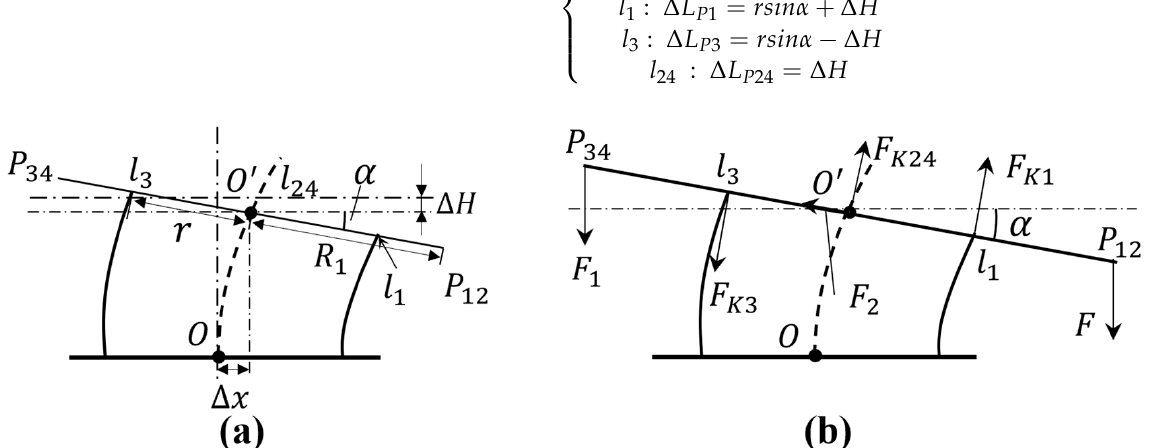
Figure 8. Analysis of the bending movement of the upper half of the module. ( a ) Analysis of the posture change of the upper part when the module is bent. ( b ) Analysis of the plane stress of the upper plate when the module is bent.